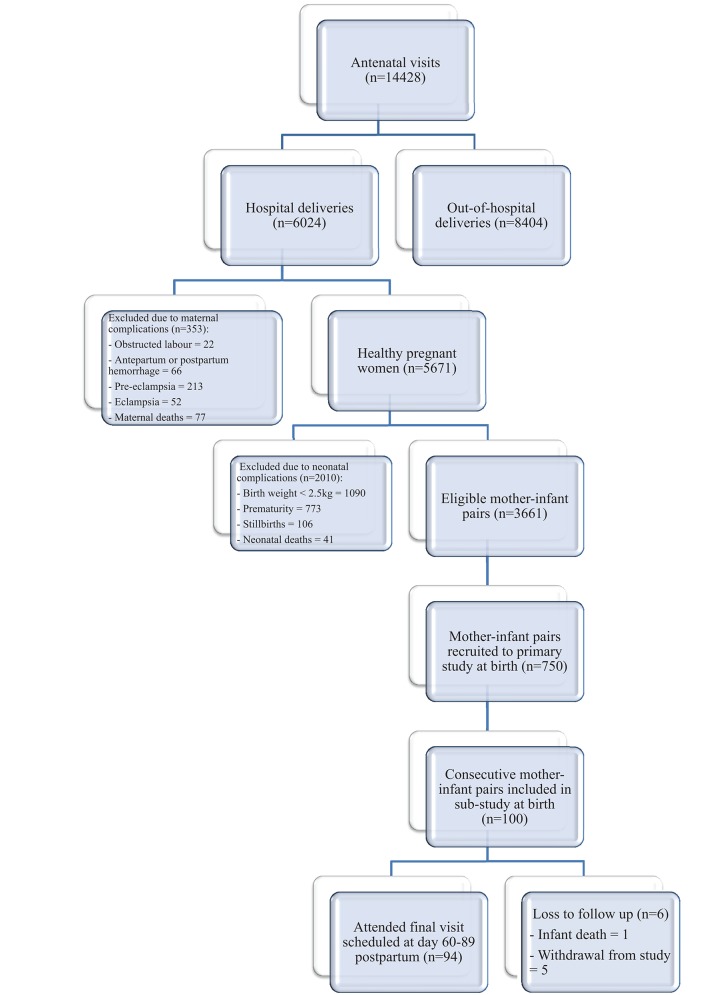
Flow diagram to demonstrate recruitment, retention and loss to follow up (34).